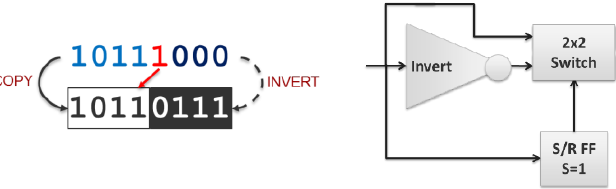
Figure 9. Hop count decrement as a serial process ( left ); combining inversion and copy ( right ).